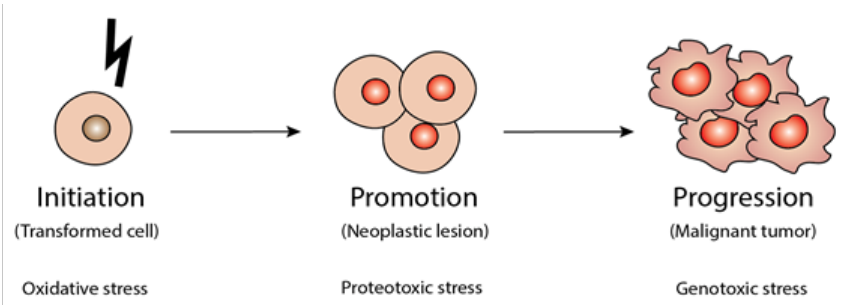
Figure 1. The di ff erent types of stress associated with the three stages of carcinogenesis. Carcinogenesis has been traditionally divided in three stages: initiation, promotion and progression. Di ff erent types of cellular stress have been implicated in these stages. Oxidative stress and reactive oxygen species (ROS) damage proteins and membranes, and induce DNA mutations. Incipient cancer cells at the promotion stage harbor an increasing number of DNA mutations, resulting in dramatically higher levels of mutant proteins that induce proteotoxic stress. Transition to a fully malignant phenotype, i.e., progression, is thought to require chromosomal instability and resulting karyotypic abnormalities, inducing genotoxic stress. Of note, all types of stress indicated (oxidative, proteotoxic and genotoxic) play roles in all three stages of carcinogenesis described above; their relative importance likely di ff ers amongst di ff erent types of